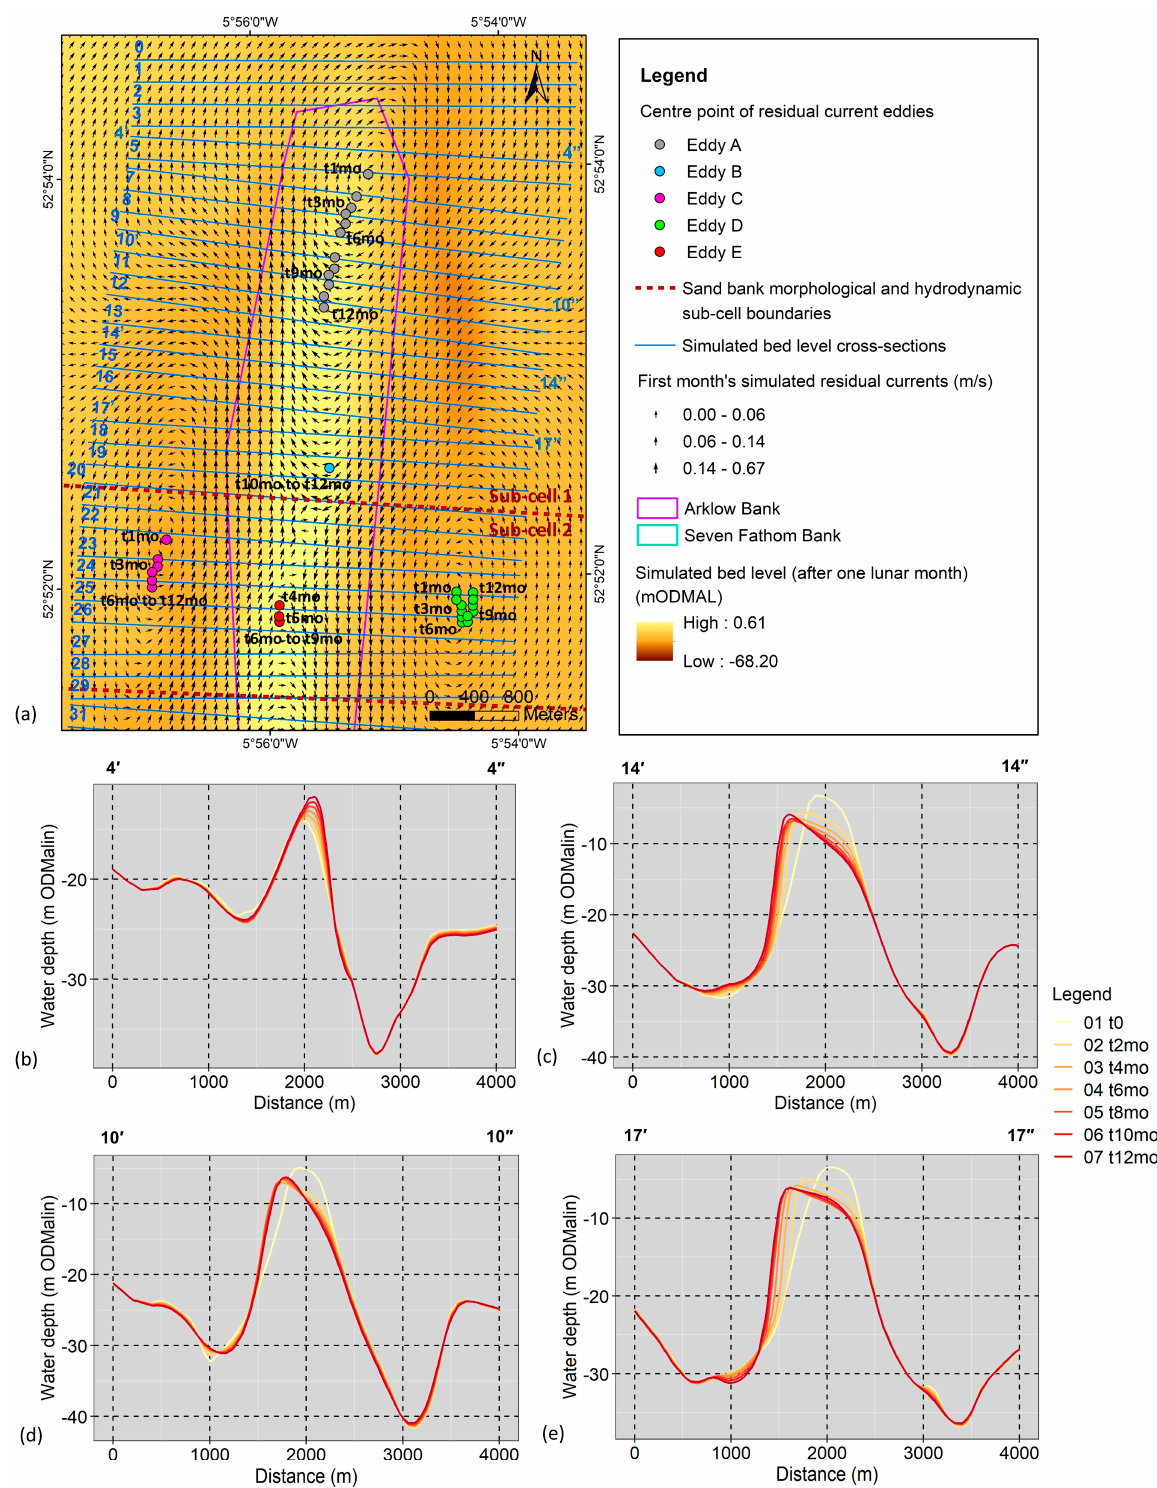
Figure 6. Morphodynamics and hydrodynamics at Sub-cell 1 of Arklow Bank. ( a ) Simulated bed level change after one lunar month and associated residual current vectors, overlain by the location of the centre point of residual eddies from residual currents during each subsequent lunar month simulation; ‘t6mo’ is the sixth lunar simulation month. ( b – e ) Simulated bed level over a one-year simulation at cross-sections 4, 14, 10 and 17; ‘t0’ is the starting bed level, and ‘mo’ is subsequent